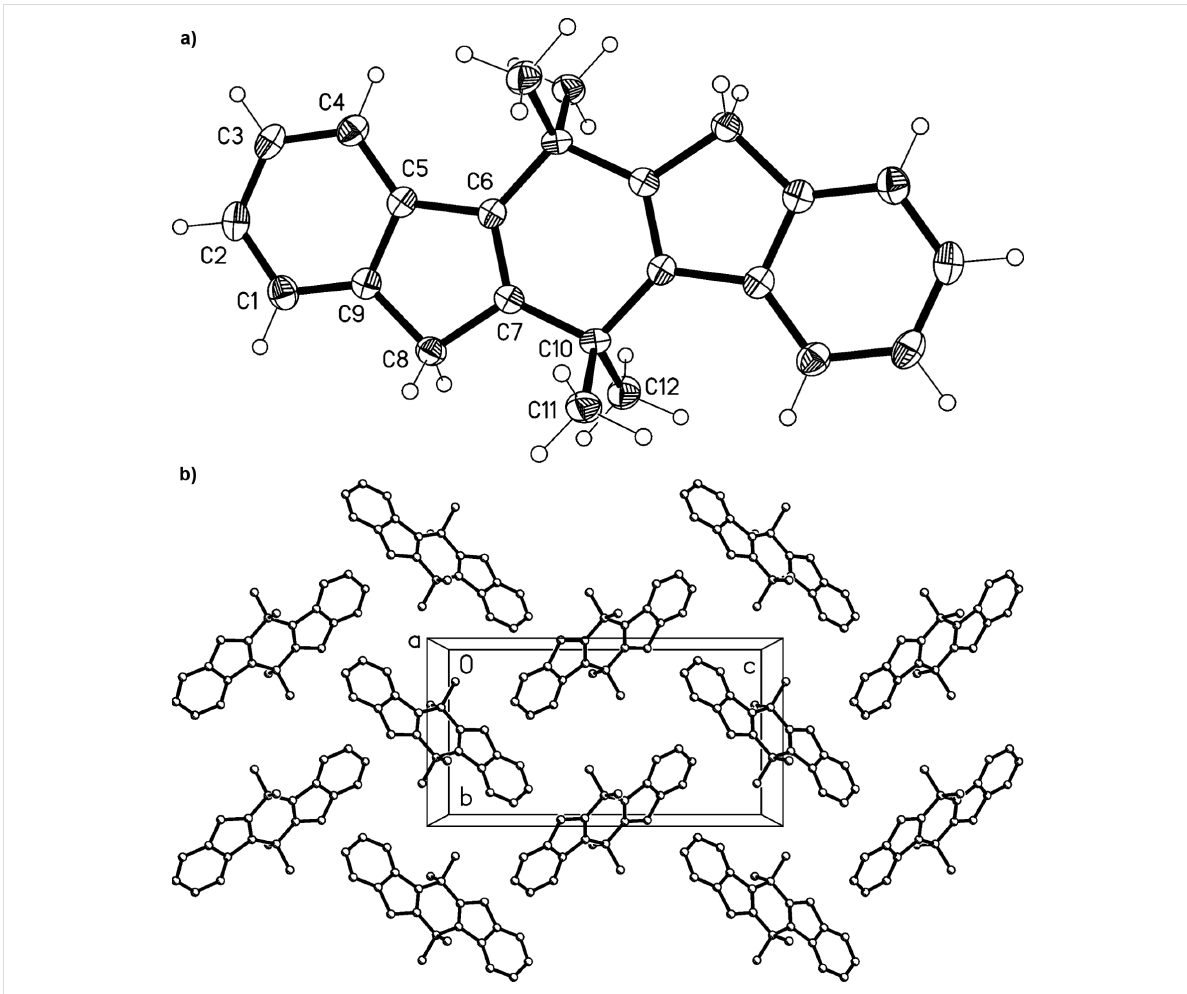
Figure 2: a) The molecule of compound 17 in the crystal; ellipsoids represent 50% probability levels. Only the asymmetric unit is numbered. b) Herringbone packing of compound 17 viewed parallel to the a -axis. H atoms are omitted.